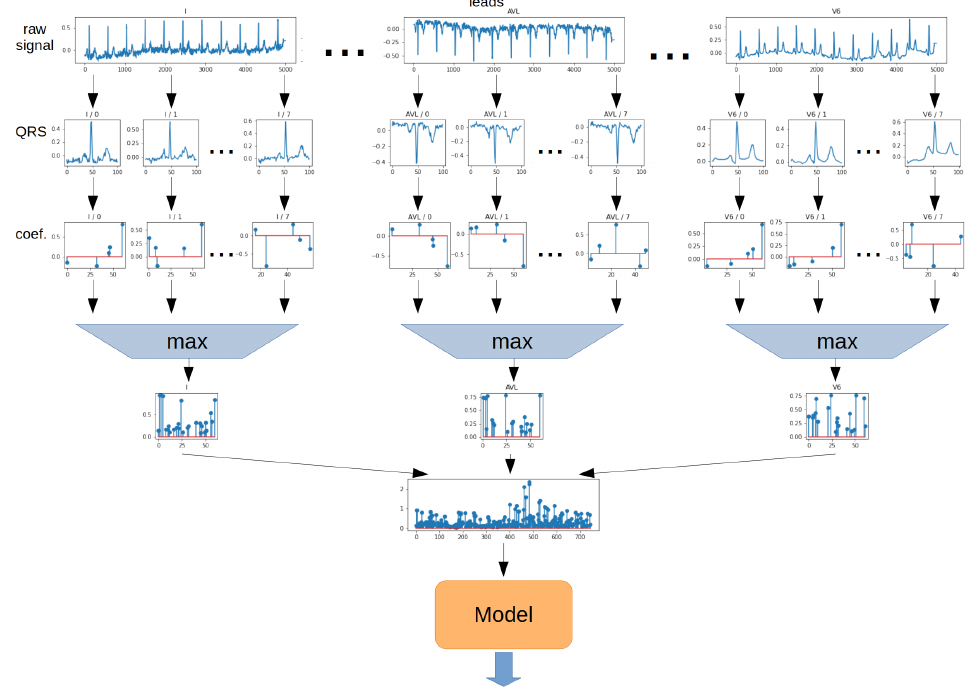
Figure 14. Aggregation